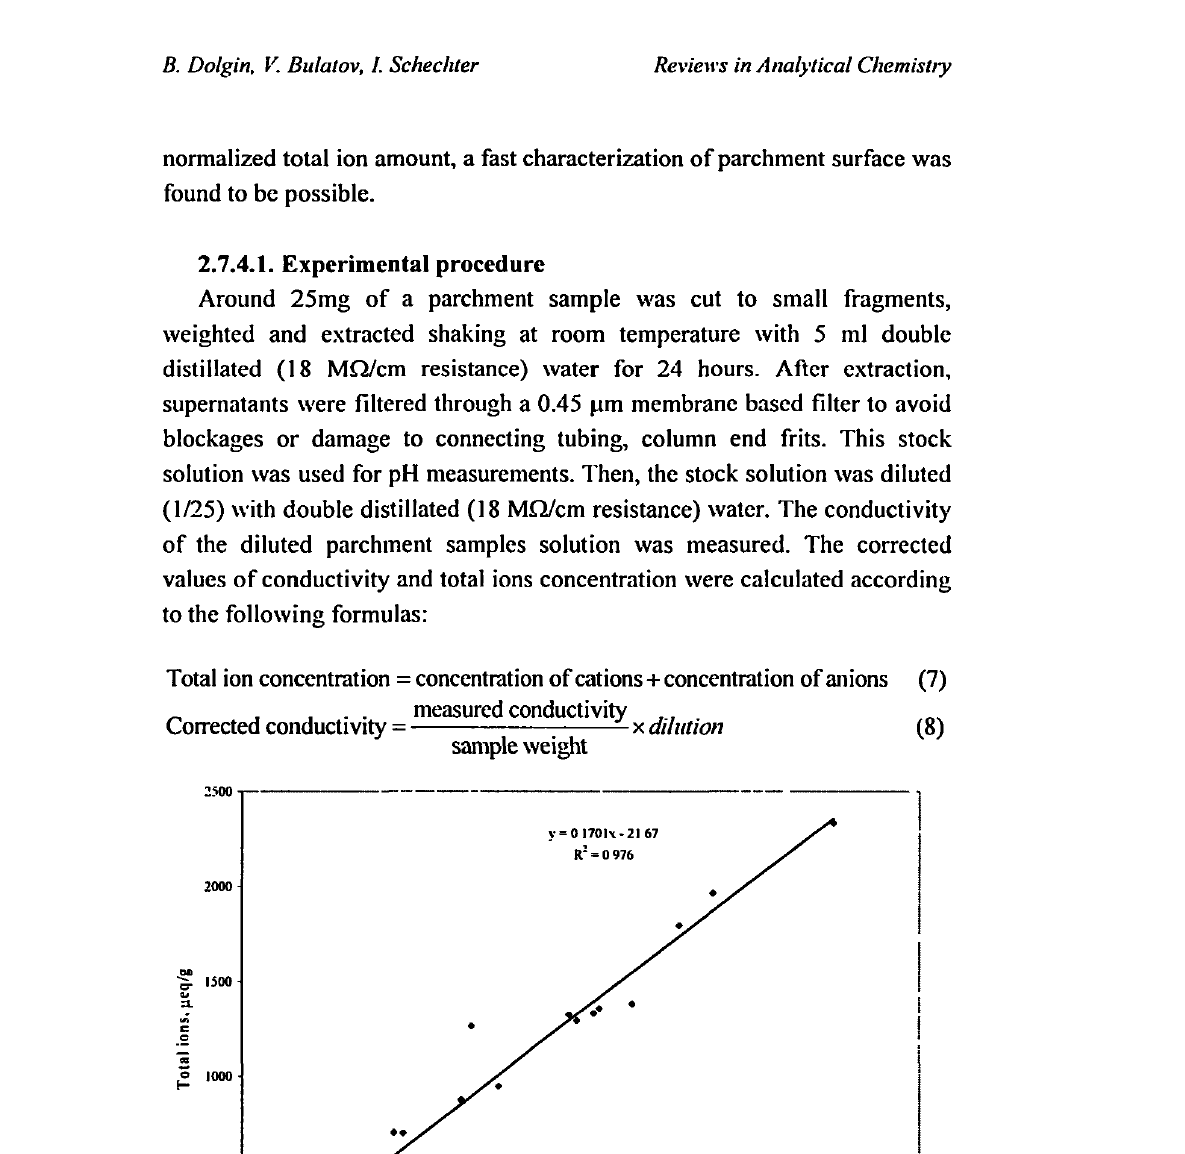
Figure 69. Correlation between conductivity and total ions